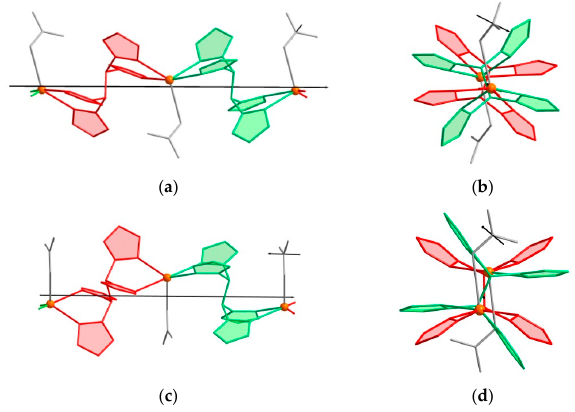
Figure 3. Fragments of the structures of 1 ( a , b ) and 2 ( c , d ). Black lines represent chain line through Ag + ions and normal lines of NO 3 − ions planes.